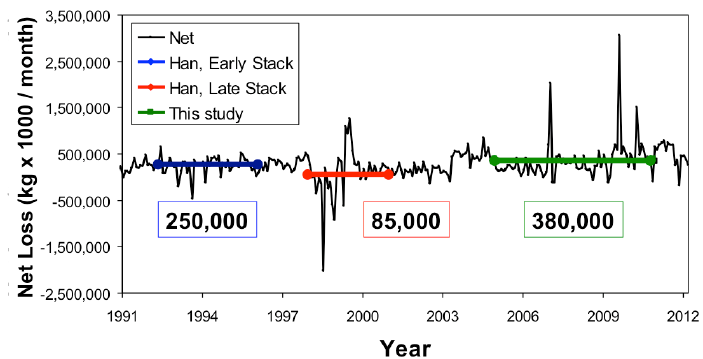
Figure 6. Net loss of water (production minus injection) at the EMGF from January 1990 to January 2012 as reported to the California Department of Conservation. Solid blue and red lines show the average net loss during two time periods during the ERS track 84 time series used by Han et al. [50], and the green line is the average net loss during Envisat track 84.